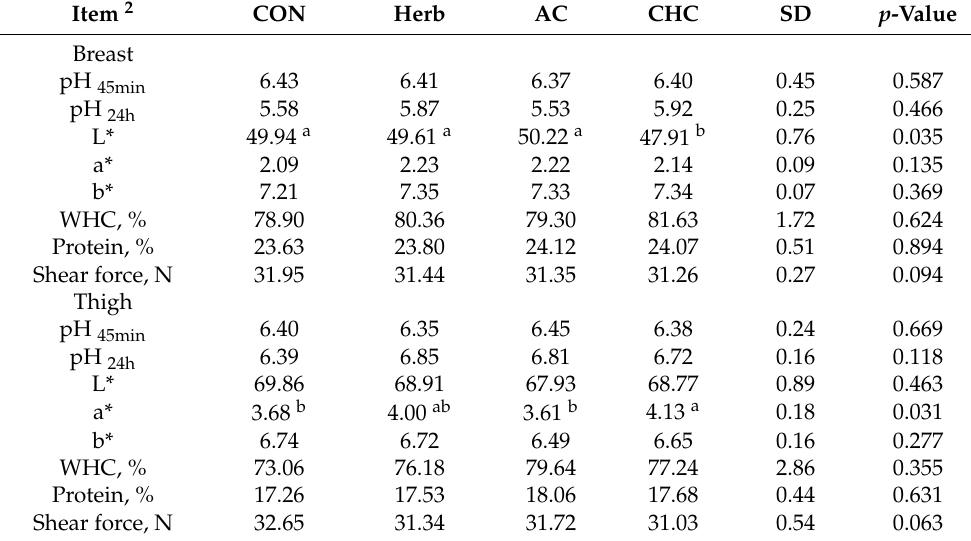
Table 4. Effects of dietary supplementation on broiler meat quality 1